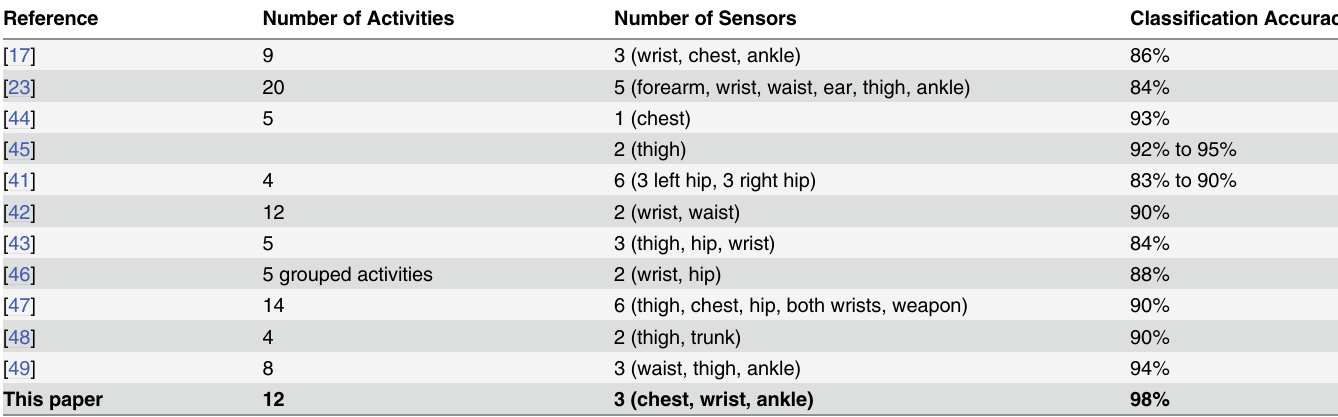
Table 12. Comparison of performance with the reported